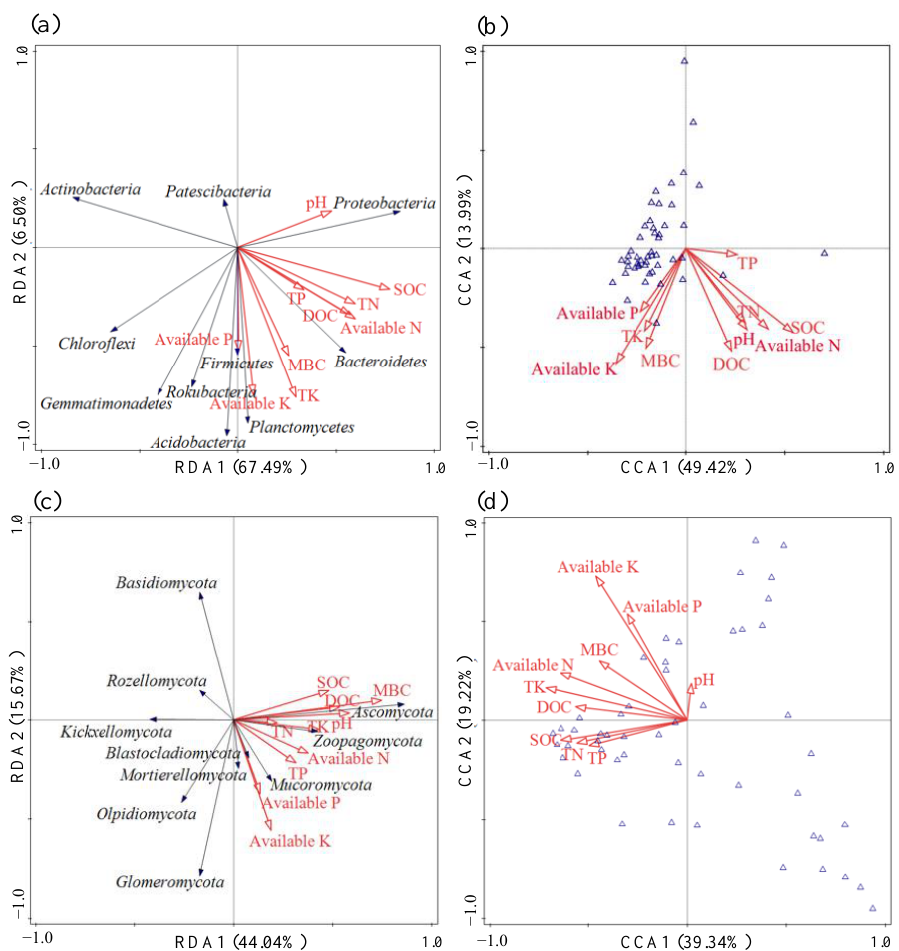
Figure 7. Redundancy analysis and canonical correspondence analysis of the relationship between soil physicochemical properties and microbial community composition. ( a ) Bacterial phylum level; ( b ) bacterial genus level; ( c ) fungal phylum level; ( d ) fungal genus level. TN, total nitrogen; TP, total phosphorus; TK, total potassium; SOC, soil organic carbon; MBC, Microbial biomass carbon; DOC, dissolved organic carbon. The red arrows represent the explanatory variables of soil properties, and the black arrows represent the top 10 soil microorganisms in abundance. The blue triangle shows the top 50 abundant soil bacteria and fungi.